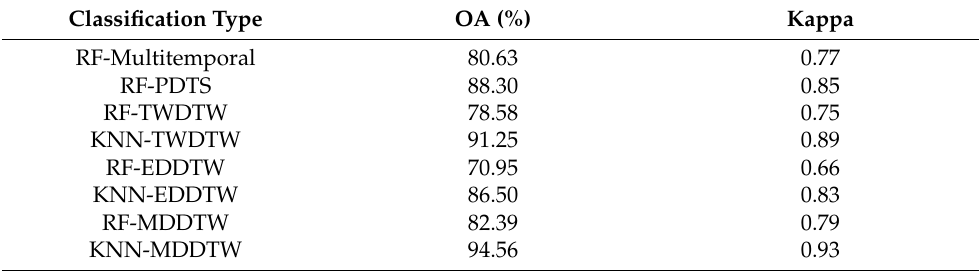
Table 2. Accuracy of different classification methods.